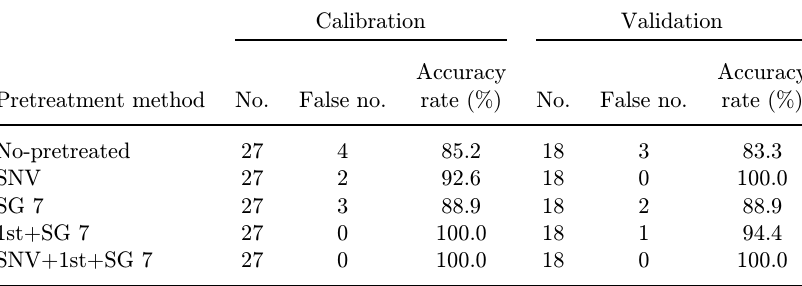
Table 3. Results of classi¯cation model of geographical origins based on di®erent spectral pretreatment methods.